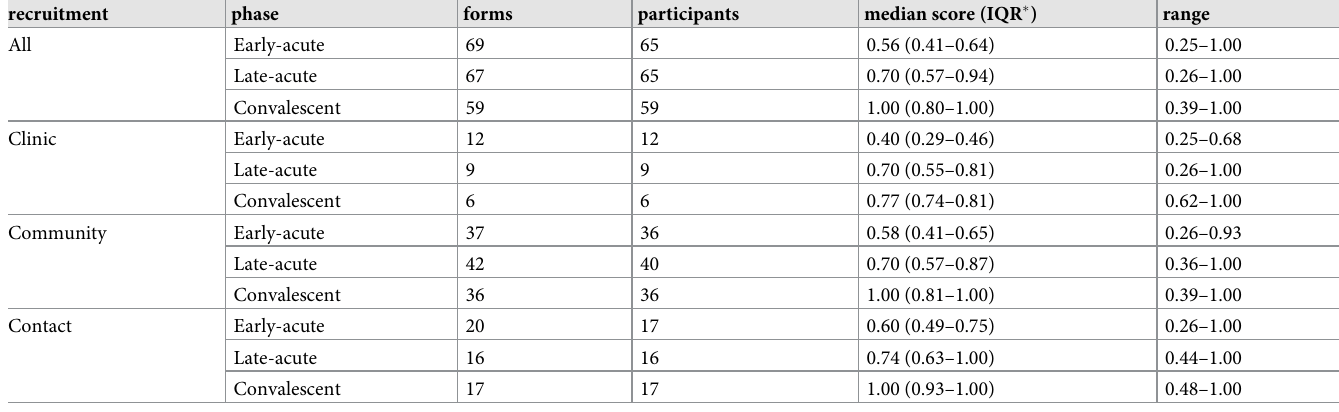
Table 2. HRQoL Scores by illness phase and recruitment